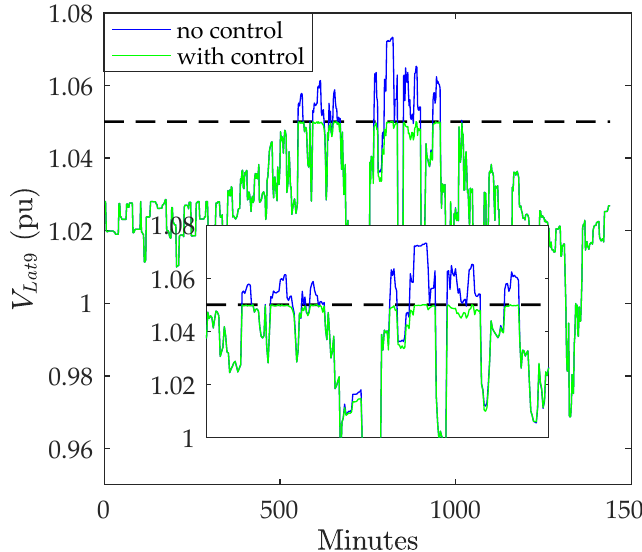
Figure 15. Voltage on lateral 9 without and with control.